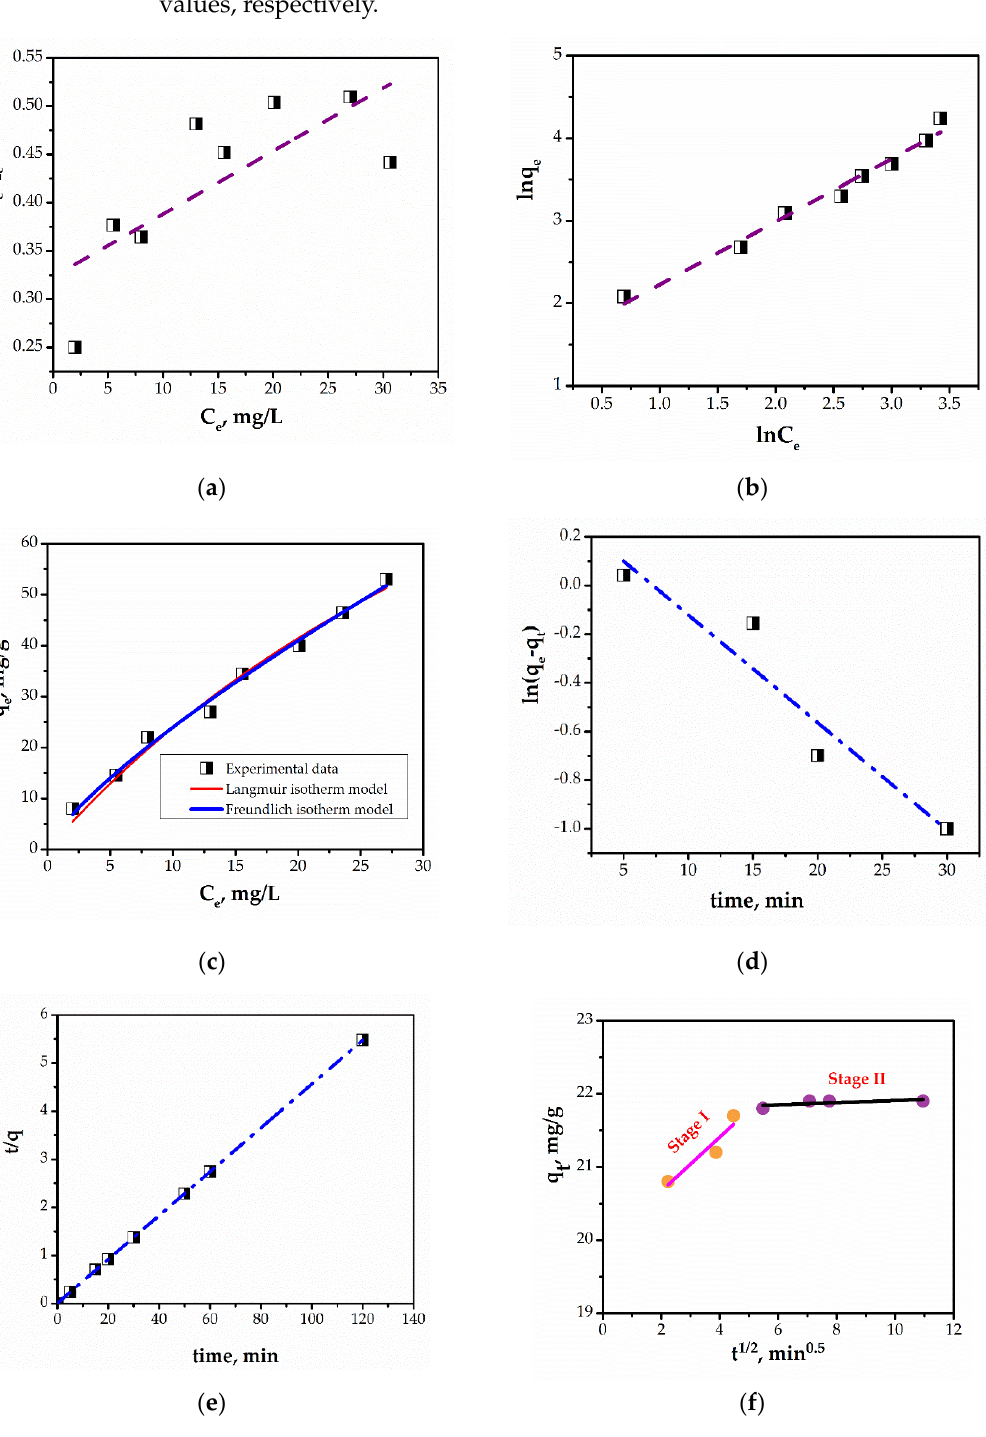
Figure 4. Fitting curves of ( a ) Langmuir model; ( b ) Freundlich model; ( c ) isotherm models in non-linear form; ( d ) pseudo-first-order model; ( e ) pseudo-second-order model; ( f ) intraparticle diffusion model.